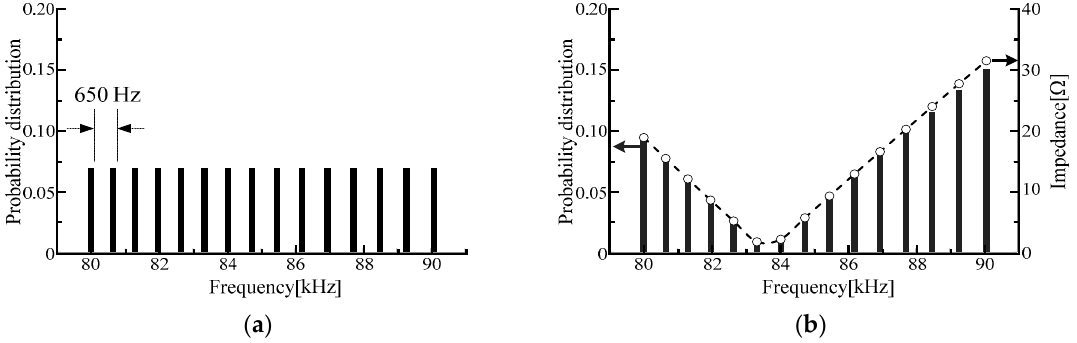
Figure 3. Probability distributions for proposed methods. Changing range of switching frequency of inverter is from 80 kHz to 90 kHz: ( a ) is the proposed method I (SSUD), and ( b ) is the proposed method II (SSBD).